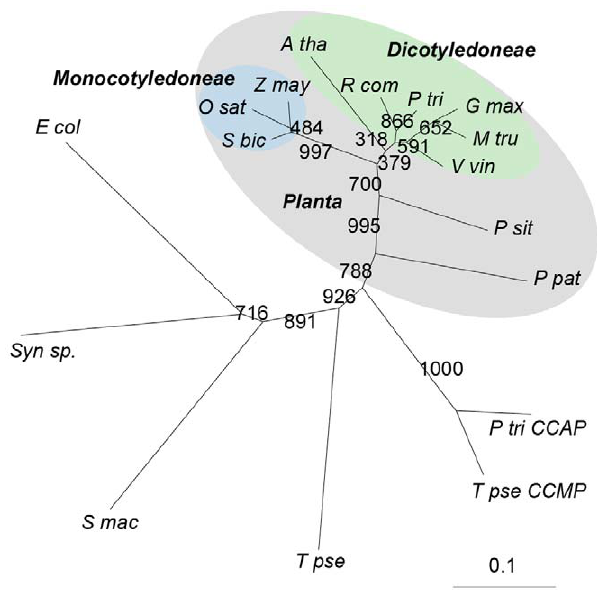
Figure 2. Unrooted tree depicting phylogenetic relationships for catalytic domains of cyanases. The tree was constructed using the neighbour-joining method. Bootstrap values were calculated on 1,000 repeats of the initial alignment using a seed value of 111. The length of lines connecting the proteins indicates the mean number of estimated substitutions per site. And the scale bar represents 0.1 substitution per site. Accession numbers for each cyanase are listed in Table 1. Cyanases from plants are highlighted in grey, cyanases from Dicotyledoneae are highlighted in green and cyanases from Mono- cotyledoneae are highlighted in blue.